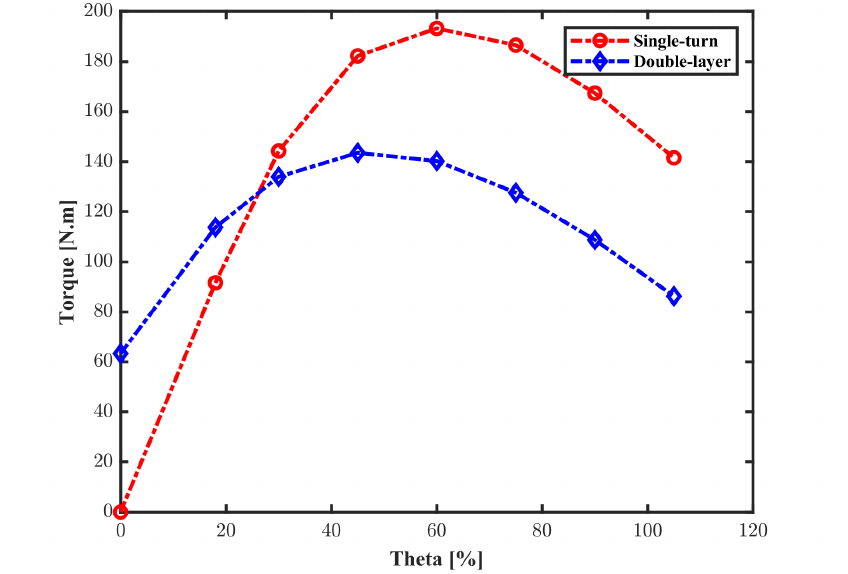
Figure 11. Winding distribution and illustration of slot fill factor.